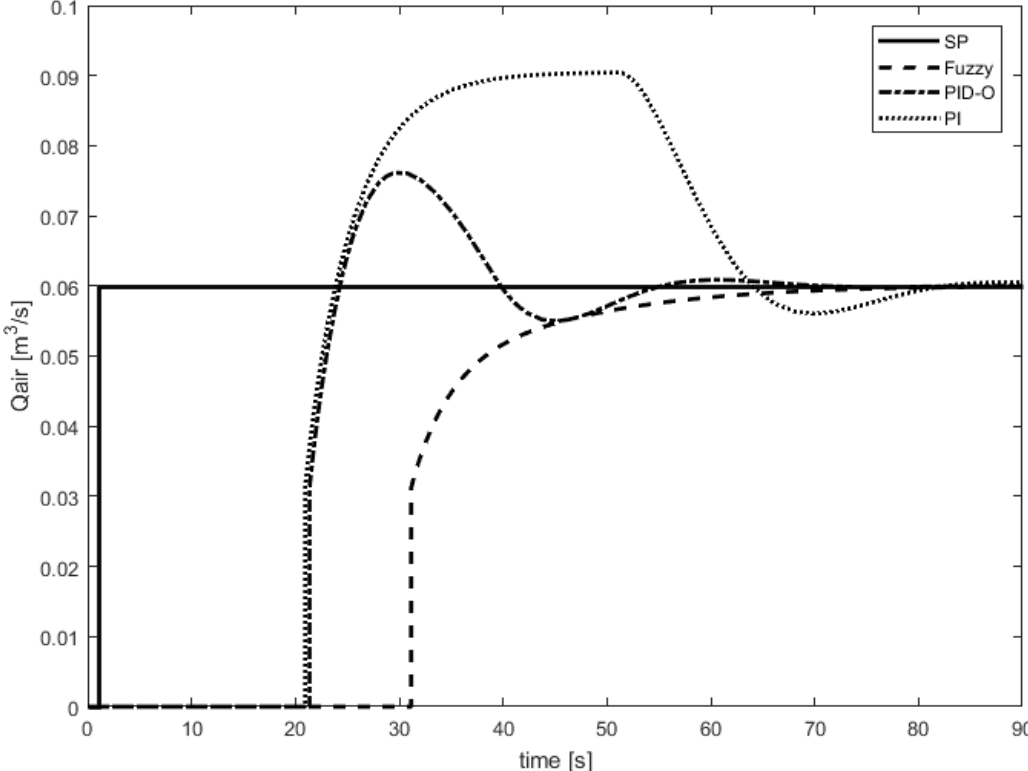
Figure 13. Comparison of control methods– Qair .